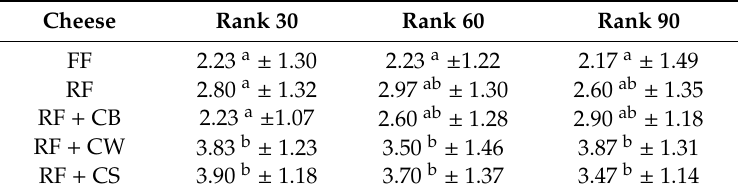
Table 4. Ranking of the cheese samples at the di ff erent periods of ripening. Lower values indicate higher positioning in the